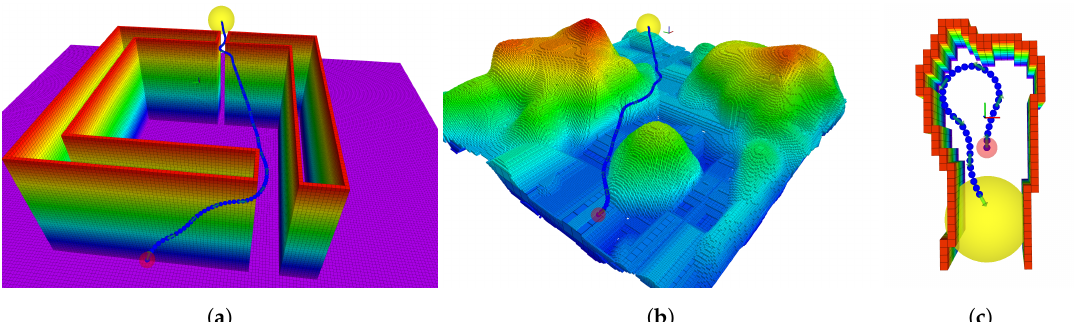
Figure 7. The three known scenarios used to compare our HA* implementation to state-lattice A*, RRT and Dubins-RRT*. The figures include the solution of HA* (The path of intermediate states in blue with green arrows for the configurations of the states). The red sphere shows the start of the query. The yellow sphere is the goal region. ( a ) Scenario 1: Gap. ( b ) Scenario 2: Canyon. ( c ) Scenario 3: Cave